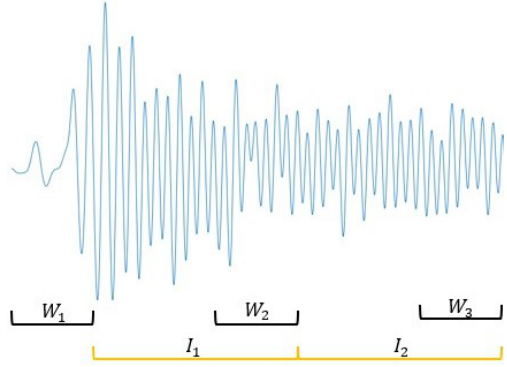
Figure 9. Data windowing